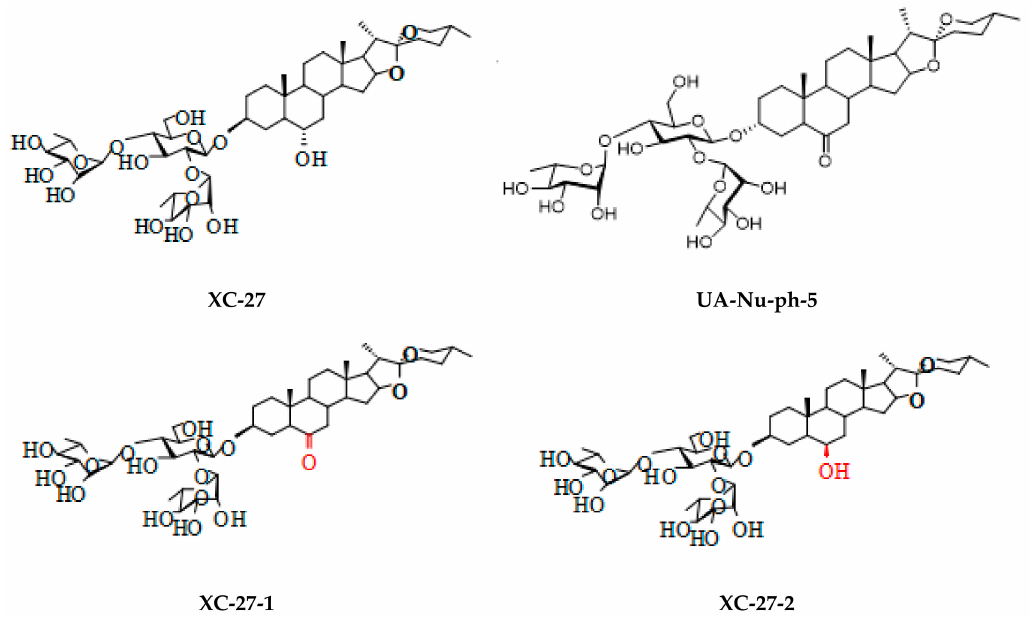
Figure 1. Chemical structures of chlorogenin 3- O - β -chacotrioside